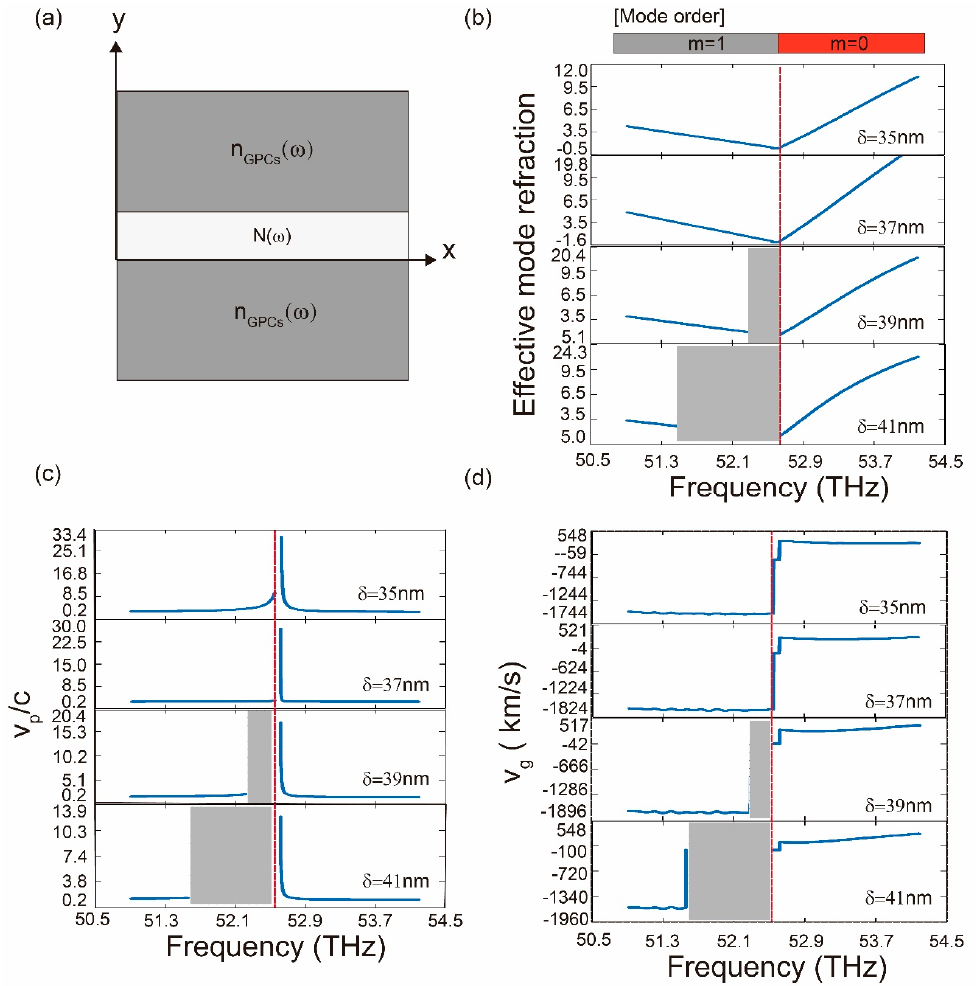
Figure 3. Schematic of a monolayer graphene plasmonic waveguide and the dispersion relation of the SPPs modes in the monolayer graphene plasmonic waveguide (MGPW). ( a ) Schematic of monolayer graphene plasmonic waveguide to calculate the dispersion relation; ( b ) e ff ective mode refraction of the SPPs modes in the MGPW; ( c ) phase velocity of the SPPs modes in the MGPW; ( d ) group velocity of the SPPs modes in the